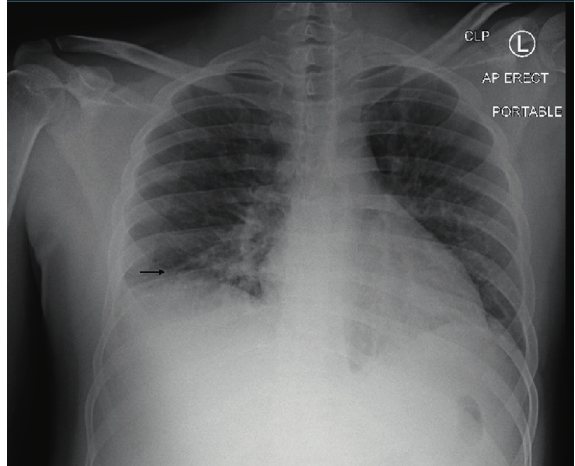
Figure 1: Suboptimal lung inflation with bibasilar atelectasis (identified by arrow). Figure